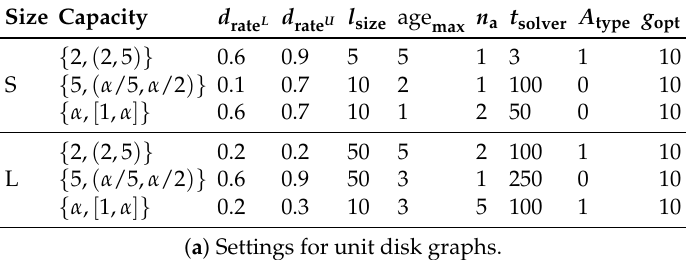
( a ) Settings for unit disk graphs.